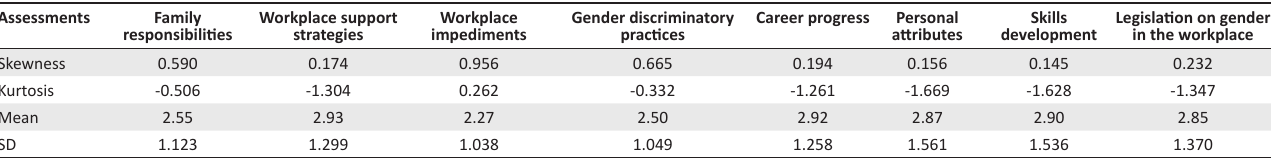
TABLE 1: Normality test and central tendencies.